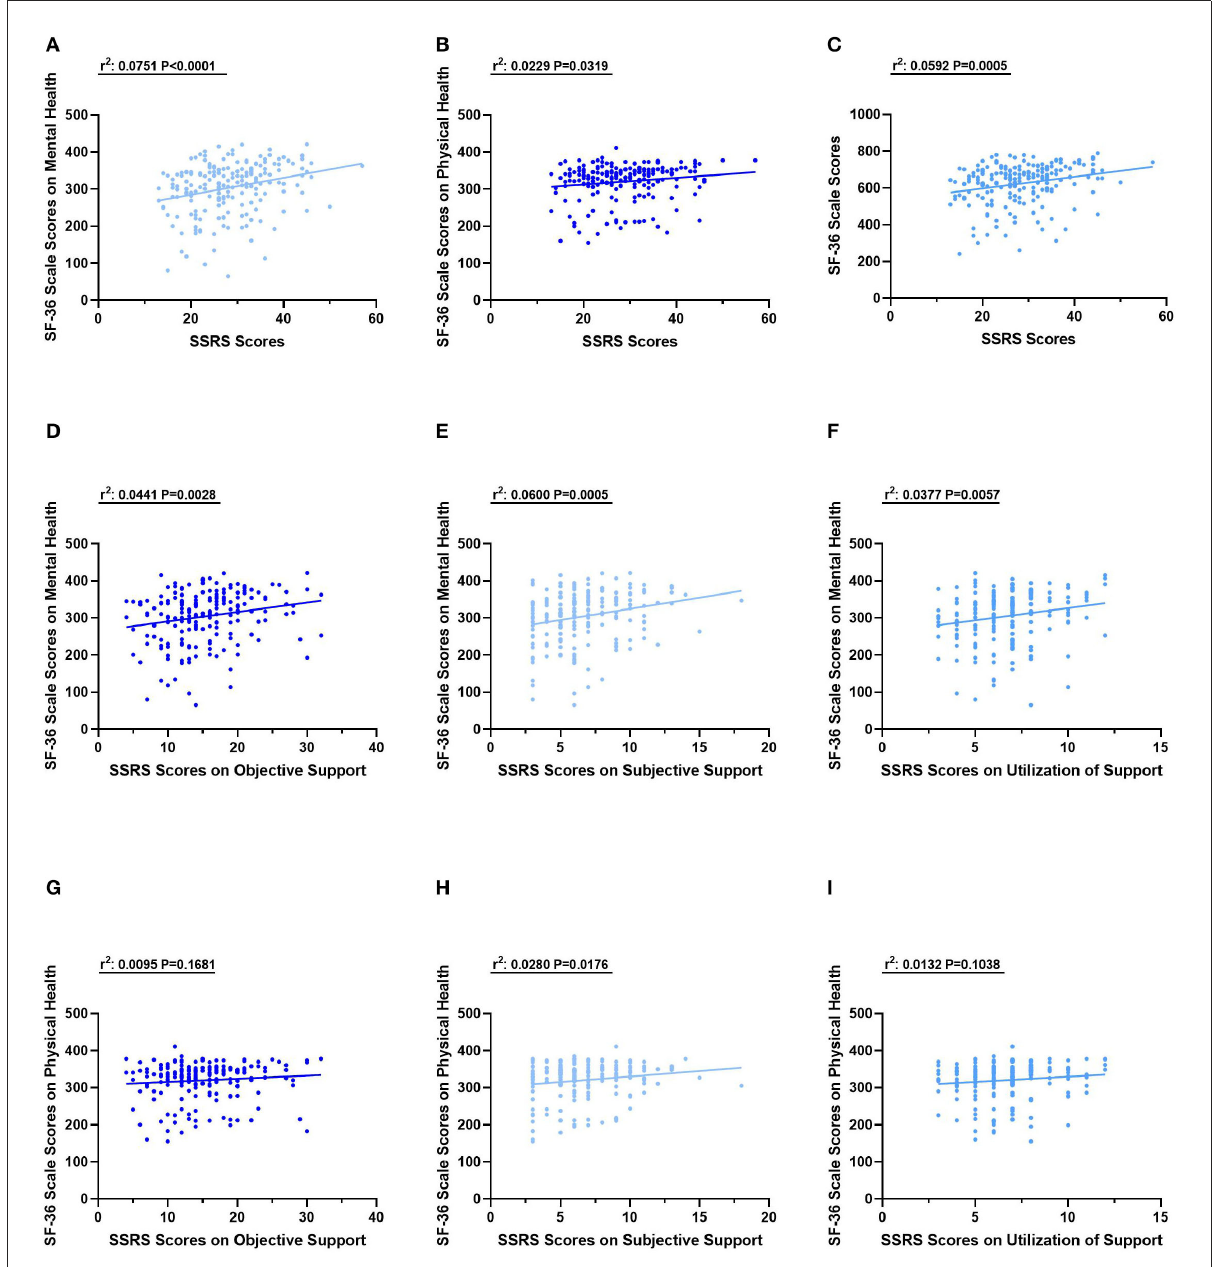
FIGURE2 The relationships between SSRS scores and SF − 36 scores. (A) The relationship between SSRS Scores and SF − 36 Scores on Mental health. (B) The relationship between SSRS Scores and SF − 36 scores on Physical health. (C) The relationship between SSRS Scores and total SF − 36 scores. (D) The relationship between SSRS Scores on Objective Support and SF − 36 scores on Mental health. (E) The relationship between SSRS Scores on Subjective Support and SF − 36 scores on Mental health. (F) The relationship between SSRS Scores on Utilization of Support and SF − 36 scores on Mental health. (G) The relationship between SSRS Scores on Objective Support and SF − 36 scores on Physical health. (H) The relationship between SSRS Scores on Subjective Support and SF − 36 scores on Physical health. (I) The relationship between SSRS Scores on Utilization of Support and SF − 36 scores on Physical